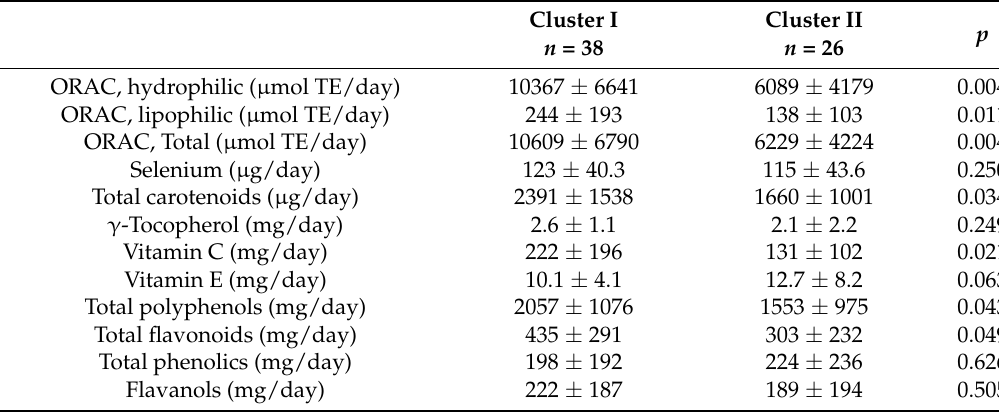
Table 6. Differences in the intake of the major dietary antioxidants between clusters.